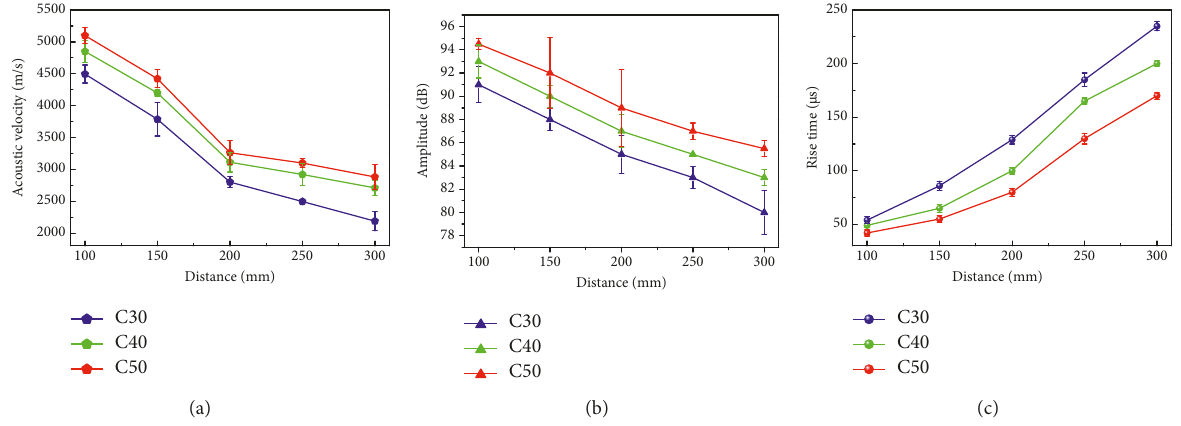
Figure 8: Characteristic parameters. (a) Acoustic velocity. (b) Amplitude. (c) Rise time versus distance curve.